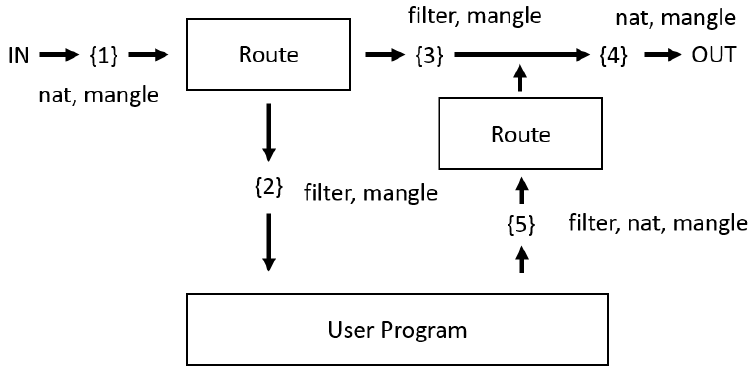
Figure 4. Netfilter hooks diagram (reference source: netfilter.org) [11].